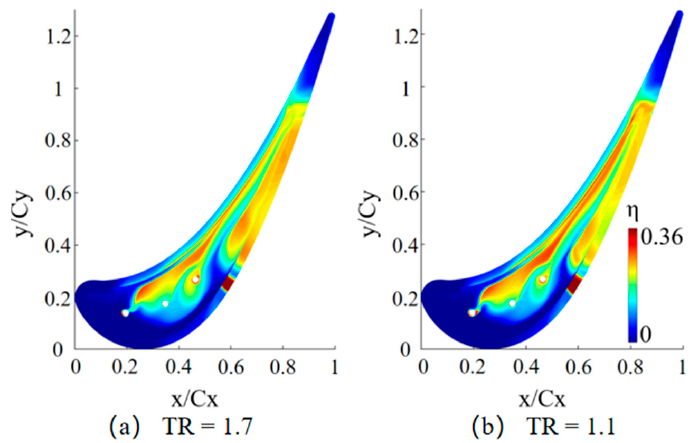
Figure 11. Comparison of coolant mass fraction distribution on the squealer tip surface for two TRs.